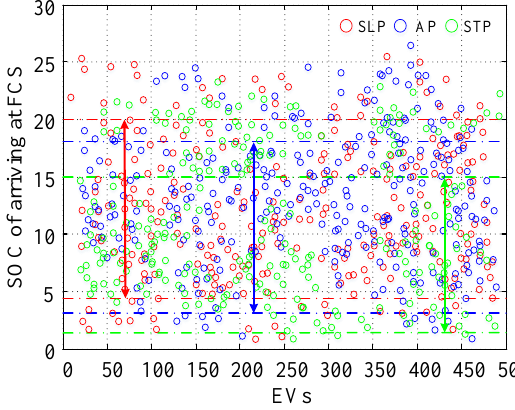
Figure 14. SOC of vehicles arriving at fast-charging station.